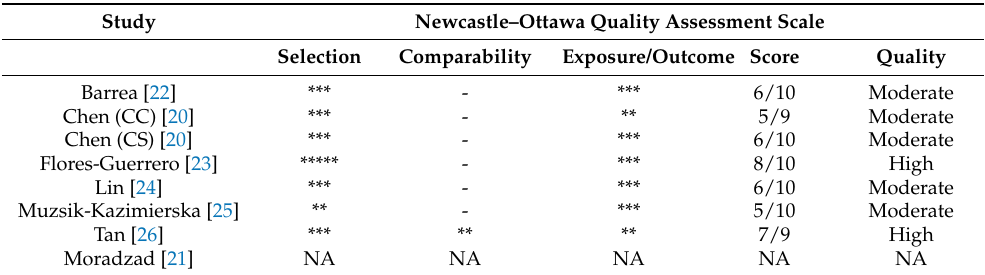
Figure 3. Inspection of an asymmetric funnel plot of the difference in trimethylamine N-oxide (TMAO) between the non-alcoholic fatty liver disease (NAFLD) and control subjects. Cohen’s d was used as the effect size metric plotted against the standard error. Table 2. Risk of bias assessment according to the Newcastle–Ottawa Quality assessment